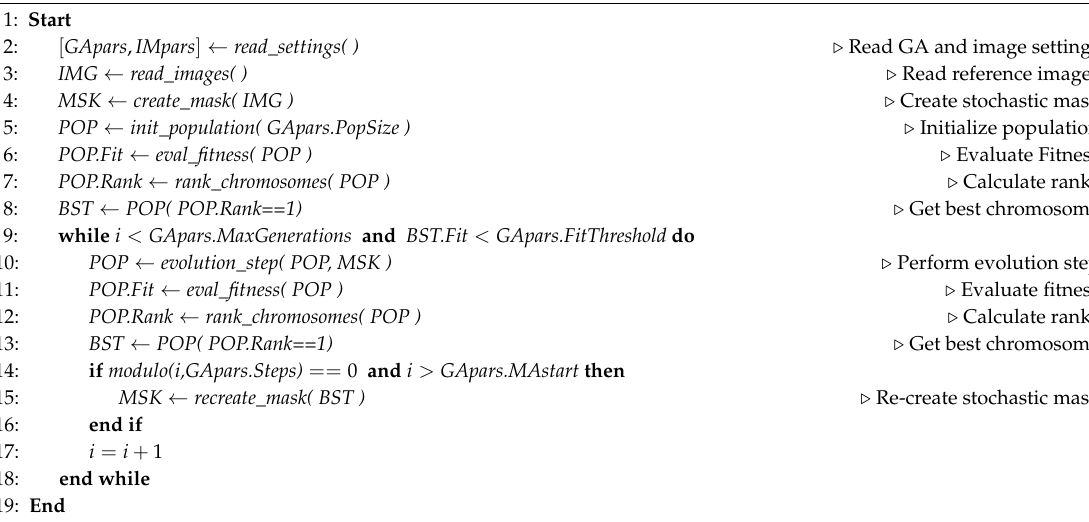
Algorithm 1 Evolutionary reconstruction